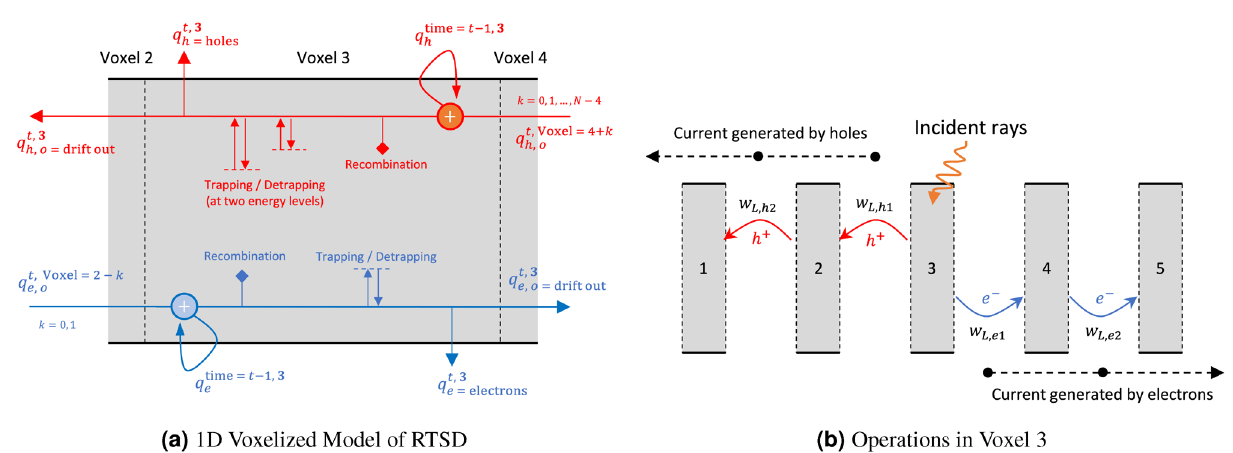
Figure 3. ( a ) Operations at voxel 3 at a particular time t. The electron transport from cathode to anode (left to right) is shown in the bottom half of this figure, while the hole transport in the opposite direction is shown in the top half of the figure. Figure adapted with permission 35 , and ( b ) Current generation in the RTSD. For simplification, we show the 1D model with only five voxels. When the γ -rays hit voxel 3, an electron–hole pair is produced. Charge transfer from one voxel to another induces a potential difference w at the electrodes. The product of transferred charge with w gives the generated current at the electrodes. Figure adapted with permission 35